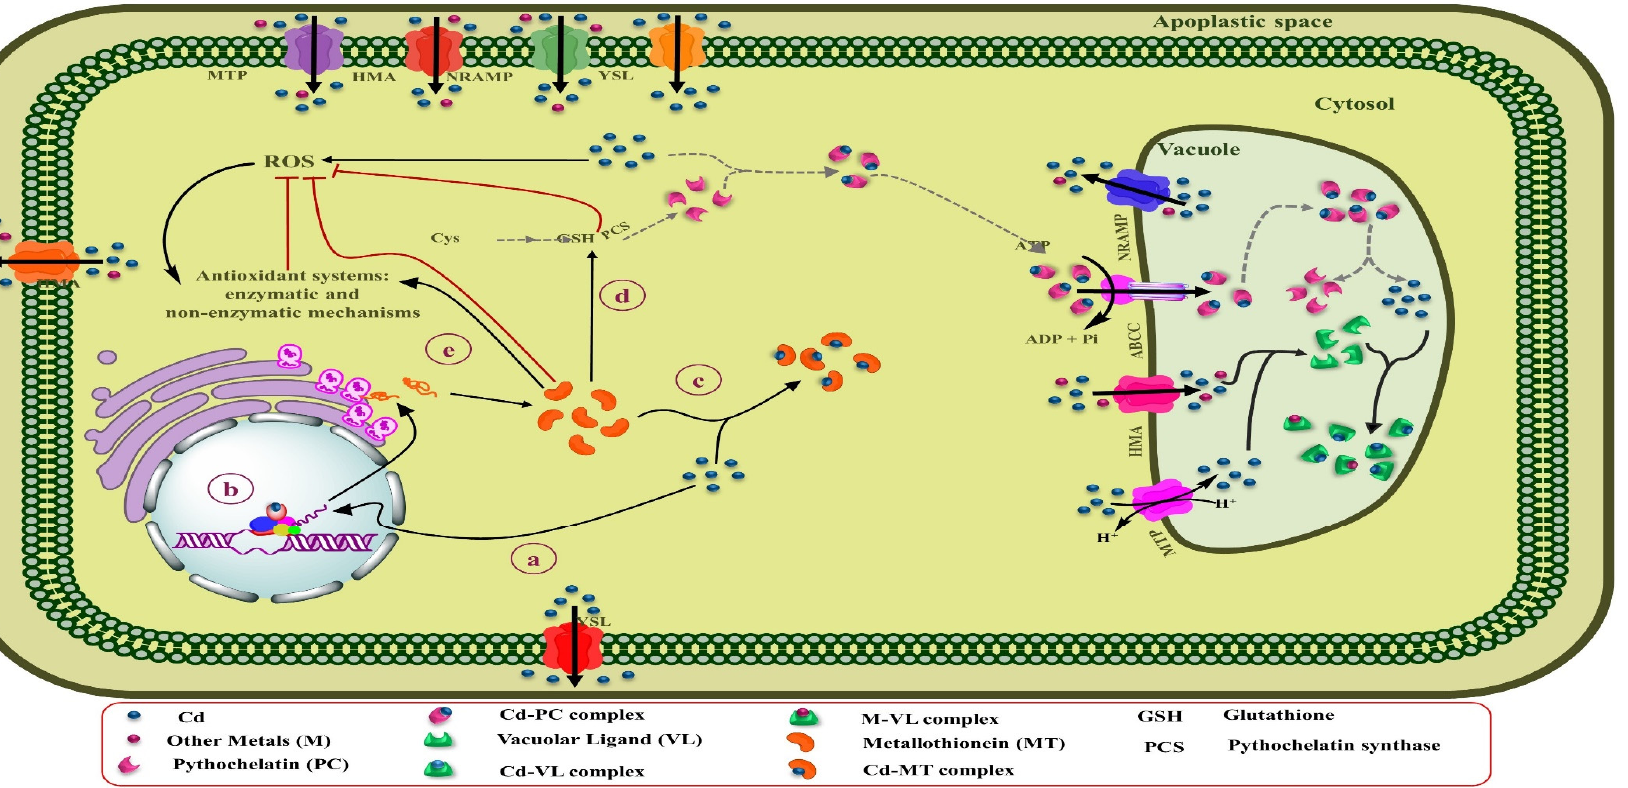
Figure 5. Schematic overview of Cd detoxification and its accumulation by MTs in leaves cells of Cd hyperaccumulator plants. ( a ) By increasing the Cd concentration in the cytosol, ( b ) Cd can stimulate the expression of the MTs gene. ( c ) By binding MTs to Cd, they can play a substantial role in detoxifying and homeostasis Cd within the cytosol. ( d ) Additionally, MTs stimulate GSH biosynthesis as the main constituent of PCs. ( e ) MTs play an essential role in ROS scavenging and its tolerance.